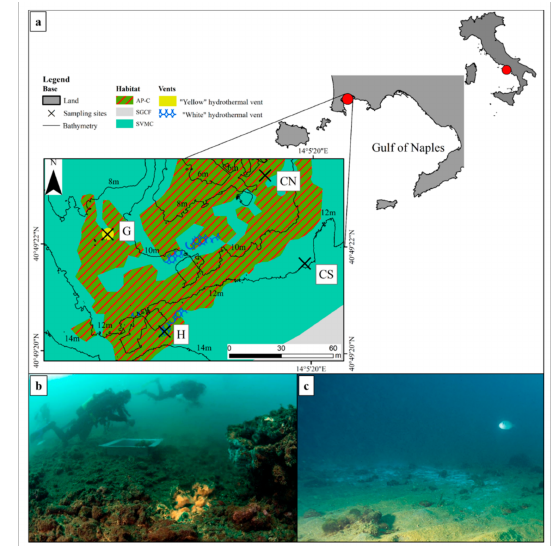
Figure 1. ( a ) Geomorphological / Habitat map of “Secca delle Fumose”. AP-C: intedigitaton between photophilous and sciaphilous habitats; SVMC: superficial muddy sands in sheltered-water habitats enriched with fragments carbonate exoskeletons of benthic organisms; SGCF: coarse sands and fine gravels mixed by the waves habitat. Sampling sites are also shown: ( b ) G site is characterized by a geyser of sulfurous hot water emissions that determine a yellow mat; ( c ) H site is characterized by carbon dioxide emissions with formation of a white bacterial mat; CN, and CS are the control / inactive